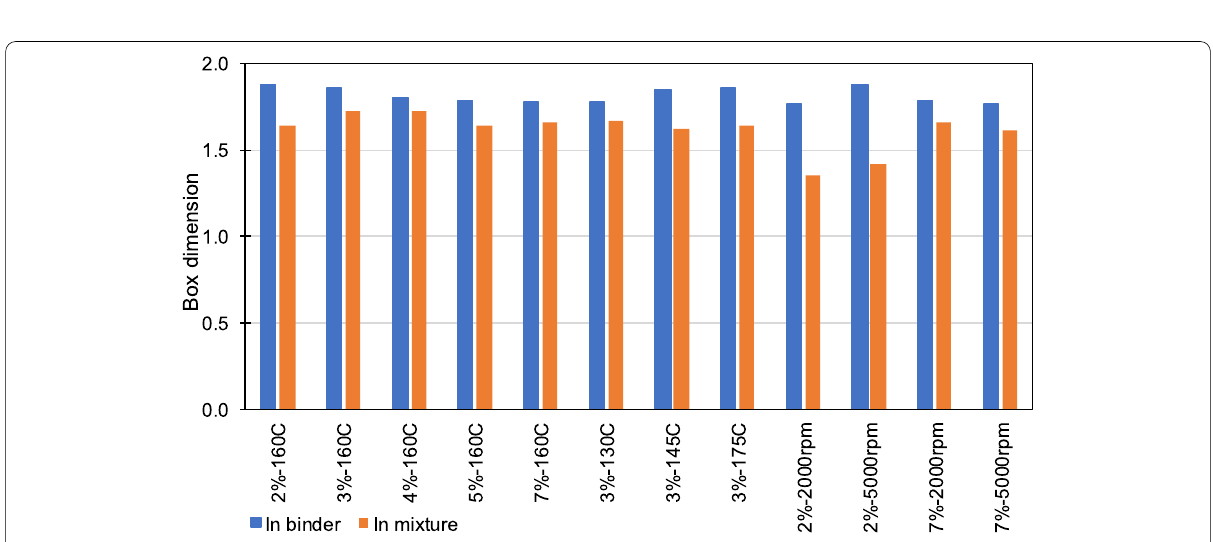
Fig. 14 Comparison of box dimension in asphalt binder and their